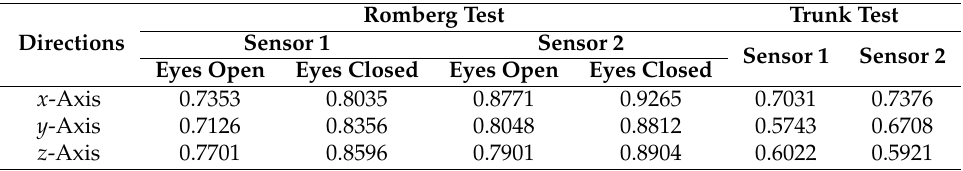
Table 2. Discrimination evaluation based on area under ROC curve (AUC)